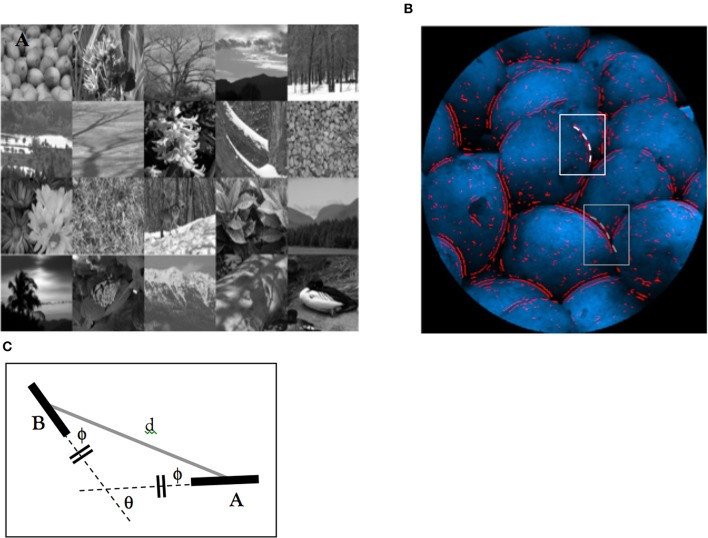
Image preparation. (A) Examples, of images of natural scenes. (B) Red lines show edge-elements extracted. In (B), white and gray-boxed areas represent a mapped contour that is continuous (and marked by our search algorithm) and one that is not continuous. (C) A schematic representation of a “continuous” edge-pair (after (Geisler et al., 2001)). Edge-elements (A,B) are considered to be “continuous” if the distances from intersecting lines oriented (dashed lines) are the same. Because of the law of the exterior angle of a triangle, angle θ (the orientation difference) is twice of the angle ϕ (the relative direction).